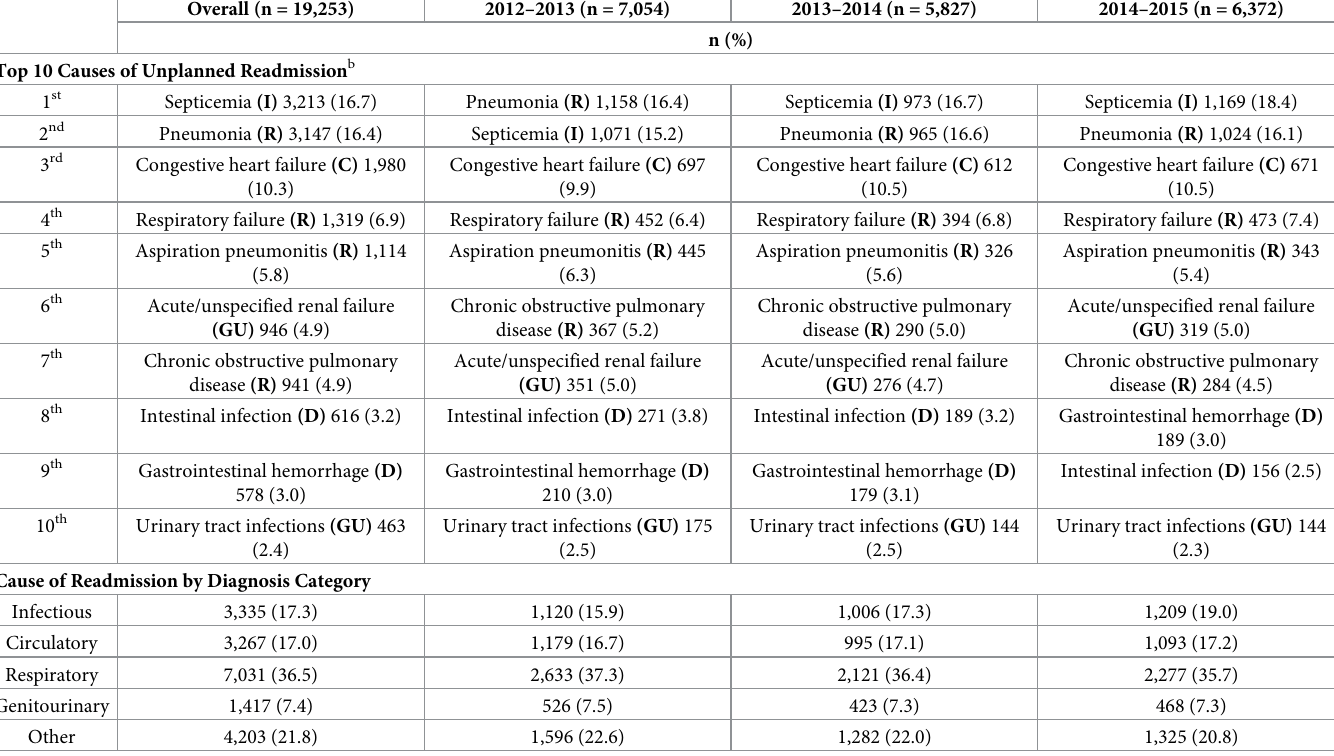
Table 2. Causes of 30-day unplanned hospital readmission among older adults discharged to skilled nursing facilities following an index hospitalization for pneu- monia, 2012–2015 a